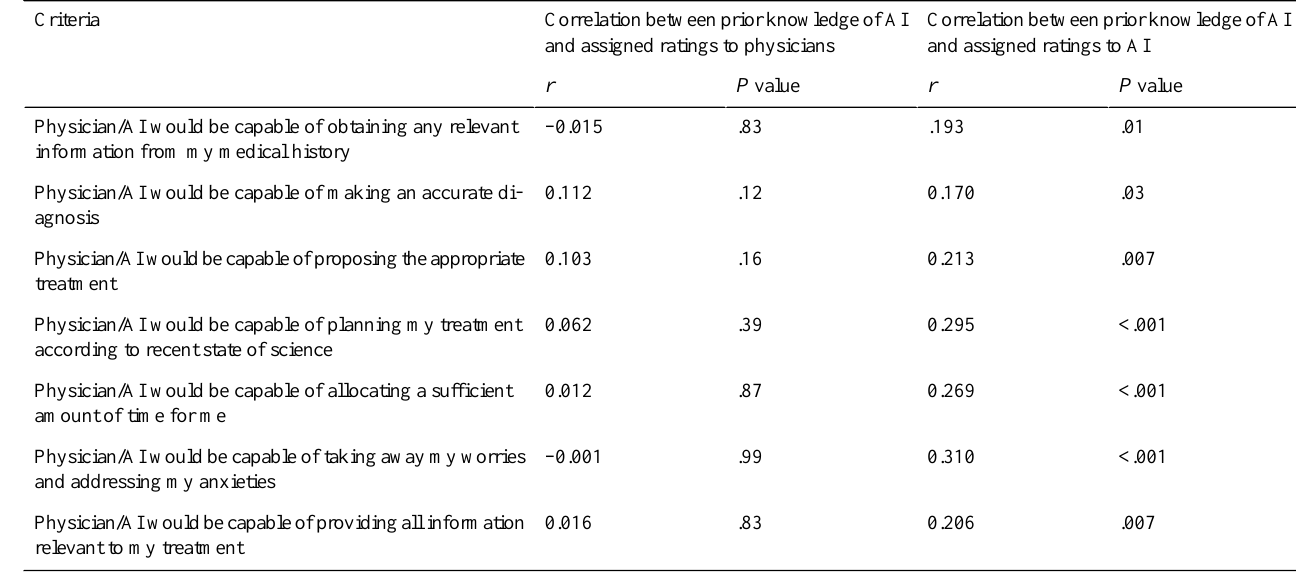
Table 3. Correlation between prior knowledge of artificial intelligence (AI) and assigned ratings for clinical capabilities of physicians and AI. physiciansCriteria